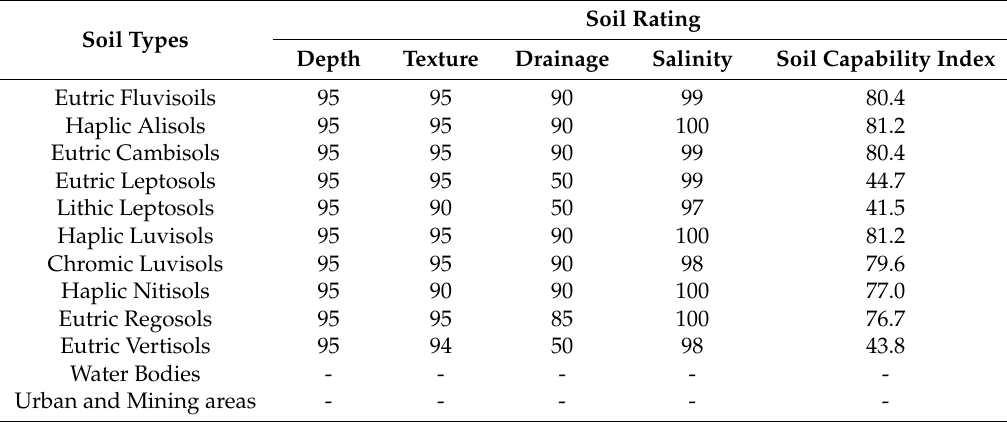
Figure 4. Reclassified factors ( a ) topography; and ( b ) land cover. Table 3. Soil types in Lake Tana Basin and their characteristics from the FAO World Soil